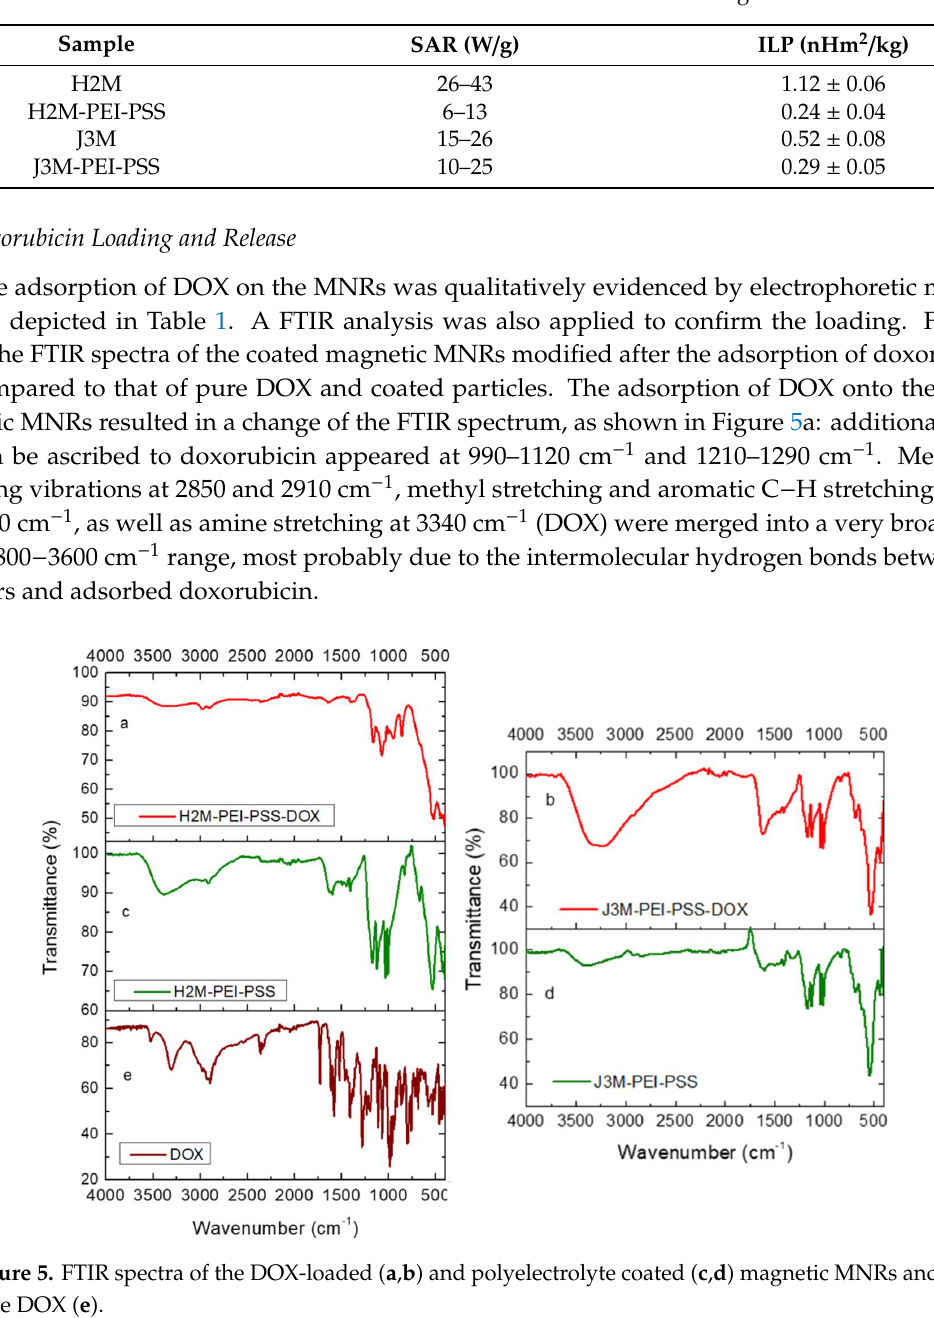
Table 3. SAR and ILP values calculated for un-coated and coated magnetic MNRs.